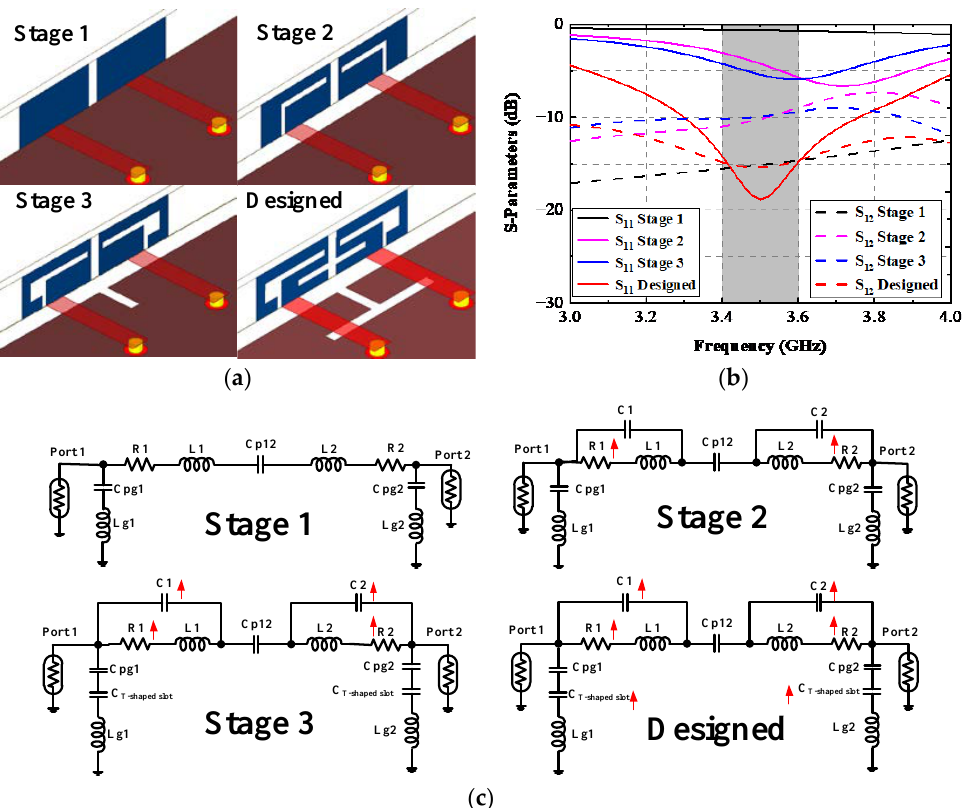
Figure 3. Simulated ( a ) design procedures, ( b ) simulated curves at each process, and ( c ) equivalent circuit of an AP at each stage.